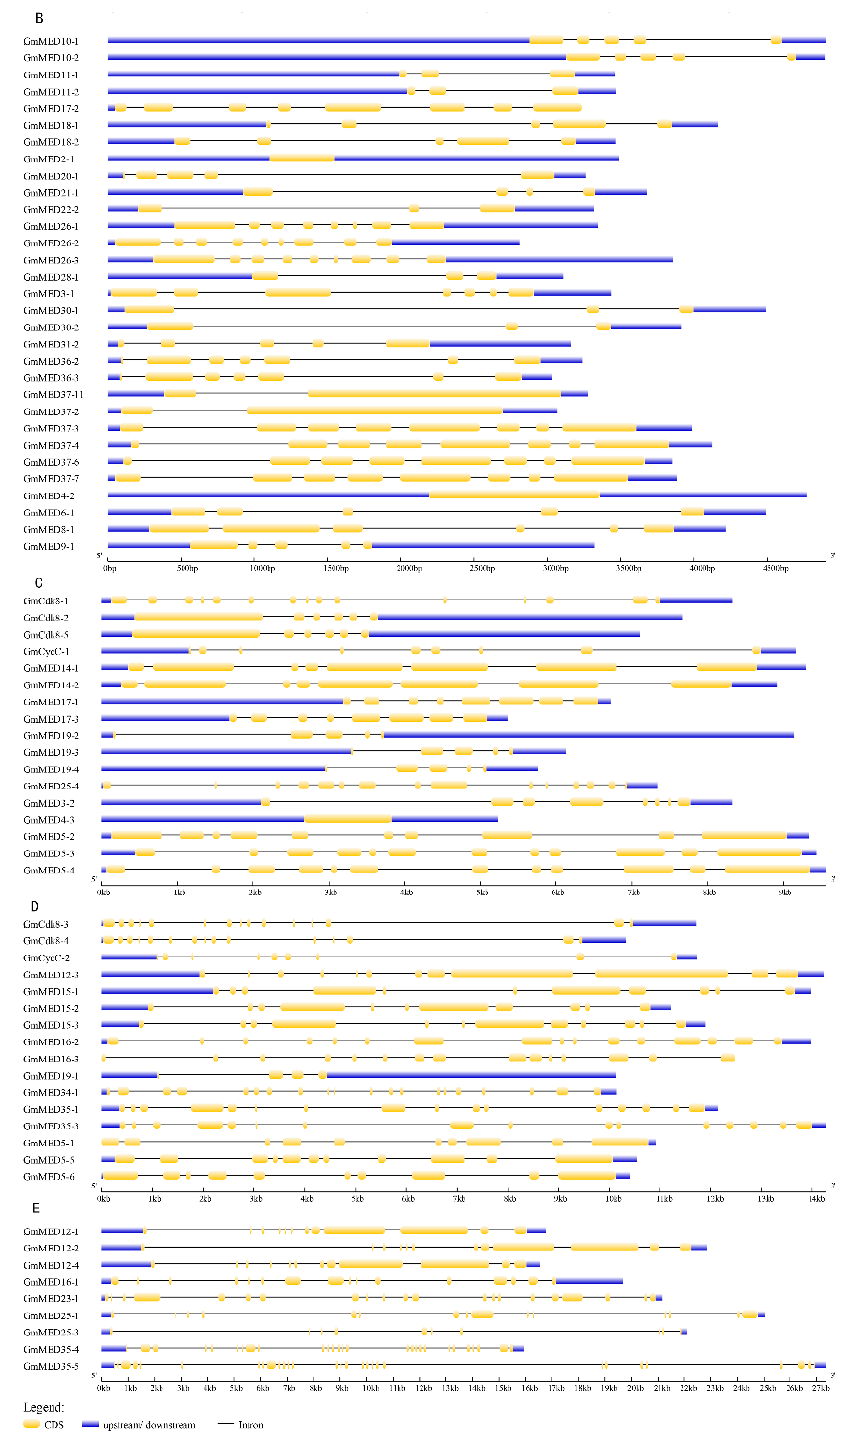
Figure 3. Gene structure of soybean mediator complex subunits. The structures of the 95 soybean mediator subunits were plotted using yellow boxes representing CDS (coding DNA sequence, exons), black lines representing introns and blue boxes indicating upstream/downstream sequences. The genes are listed by the length of the genomic sequence, from A to E represents sequence difference in size. A : <3 kb; B : 3 kb–5 kb; C : 5 kb–10 kb; D : 10 kb–15 kb; E : >15 kb The scale representing the length of each gene is on the bottom.